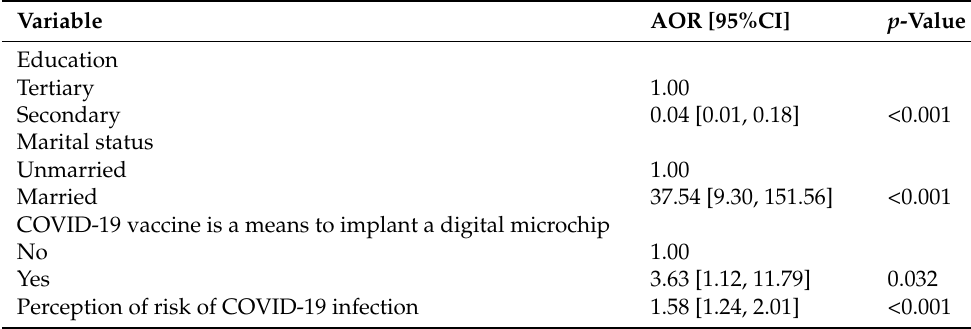
Table 2. Multiple logistic regression analysis of factors associated with non-vaccination among pregnant women in sub-Saharan